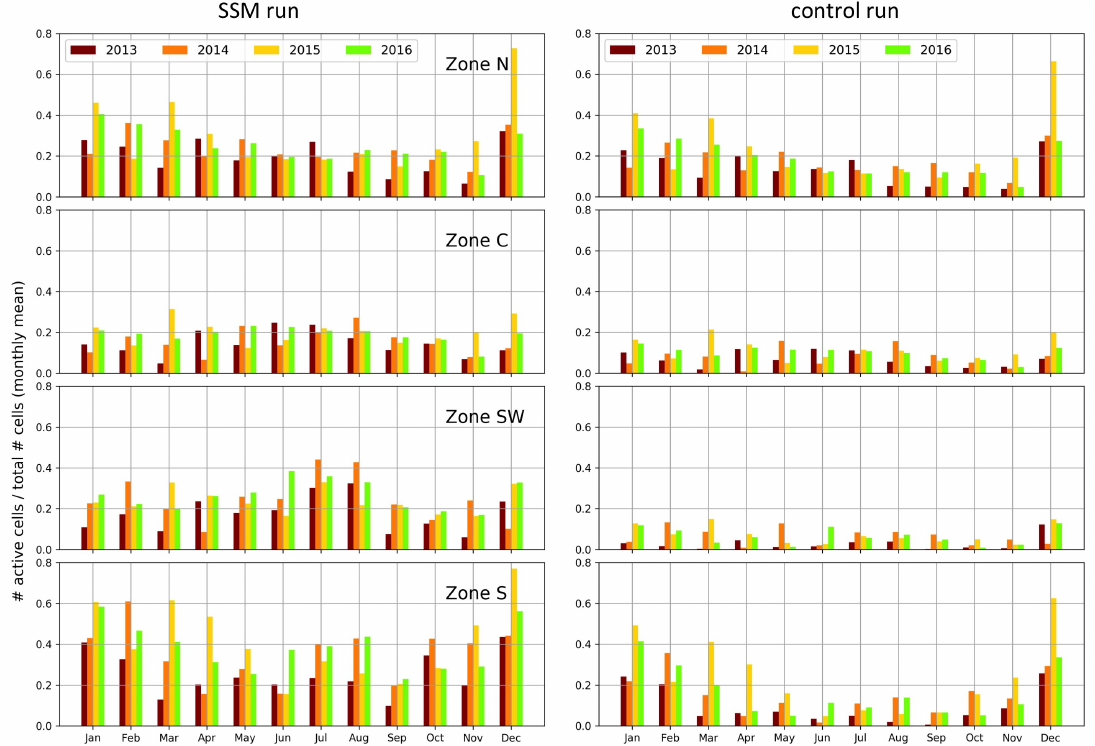
Figure 10. Temporal variability of dust activity for the grid cells within each of the hot-spot zones, derived from simulated emission flux of the SSM-run ( left ) and the control run ( right